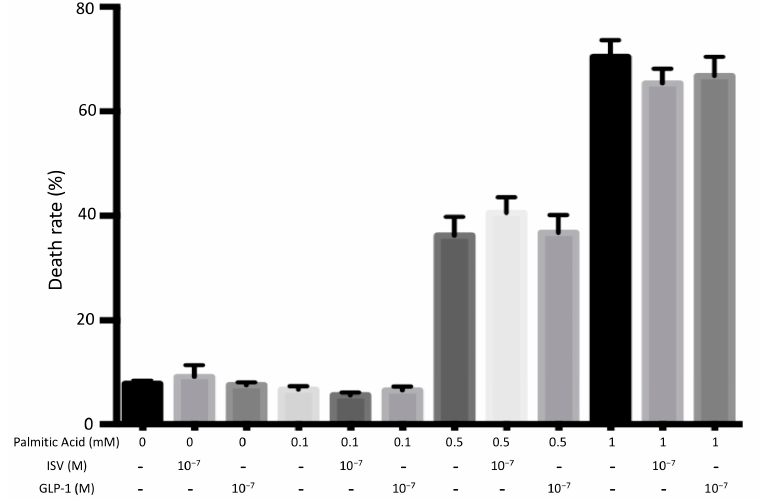
Figure 3. Effects 10 − 7 M ISV and 10 − 7 M GLP-1 on cell death rate in palmitic acid-treated INS-1E cells. We measured cell death rate following 72 h OF incubation with or without 10 − 7 M ISV and 10 − 7 M GLP-1, in the medium containing 0.1 mM, 0.5 mM, or 1 mM palmitic acid. Data are presented as the mean ± SEM of 28 samples per group from three independent expriments. The vehicle of 0 mM palmitic acid is equivalent to that of 0.5 mM palmitic